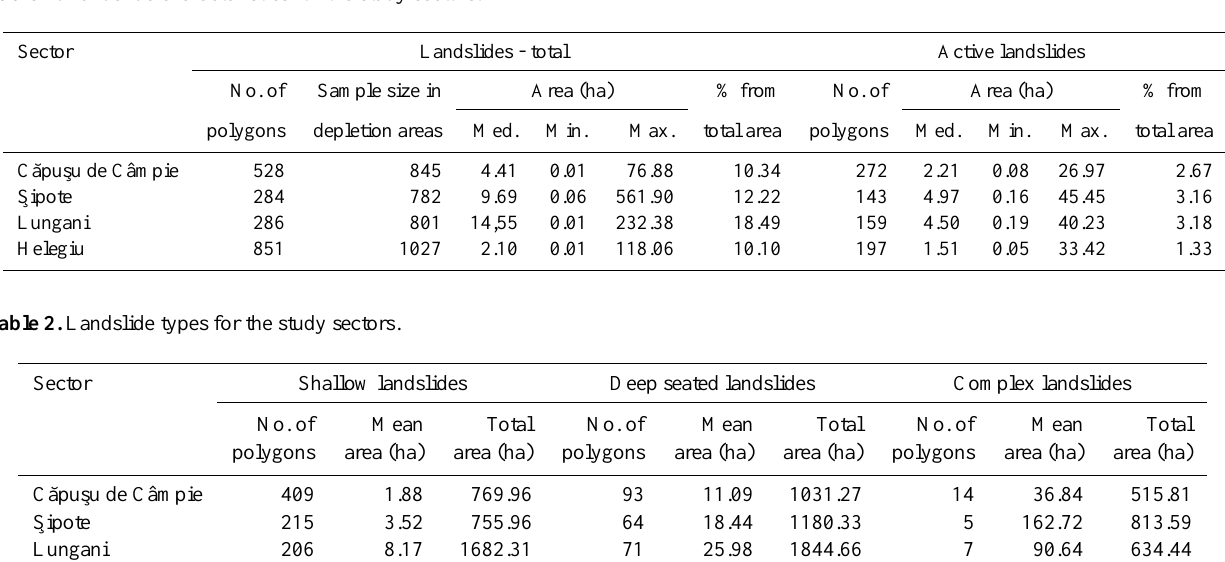
Table 1. Landslide characteristics for the study sectors. Sector Landslides - total Active landslides No. of Sample size in Area (ha) % from No. of Area (ha) % from polygons depletion areas Med. Min. Max. total area polygons Med. Min.